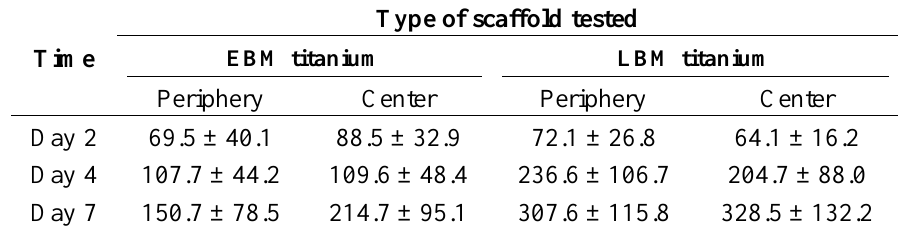
Table 1. Procollagen type 1 levels (in ng/mL) of human osteoblasts in electron-beam melting (EBM) and laser-beam melting (LBM) titanium scaffolds.